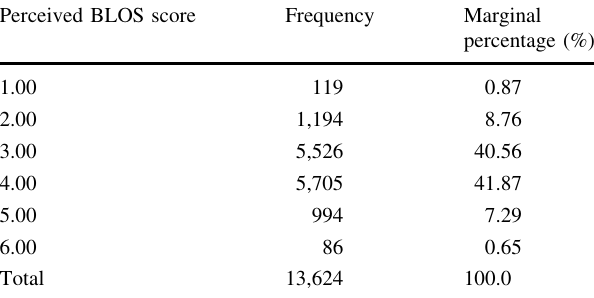
Table 1 Perception survey results